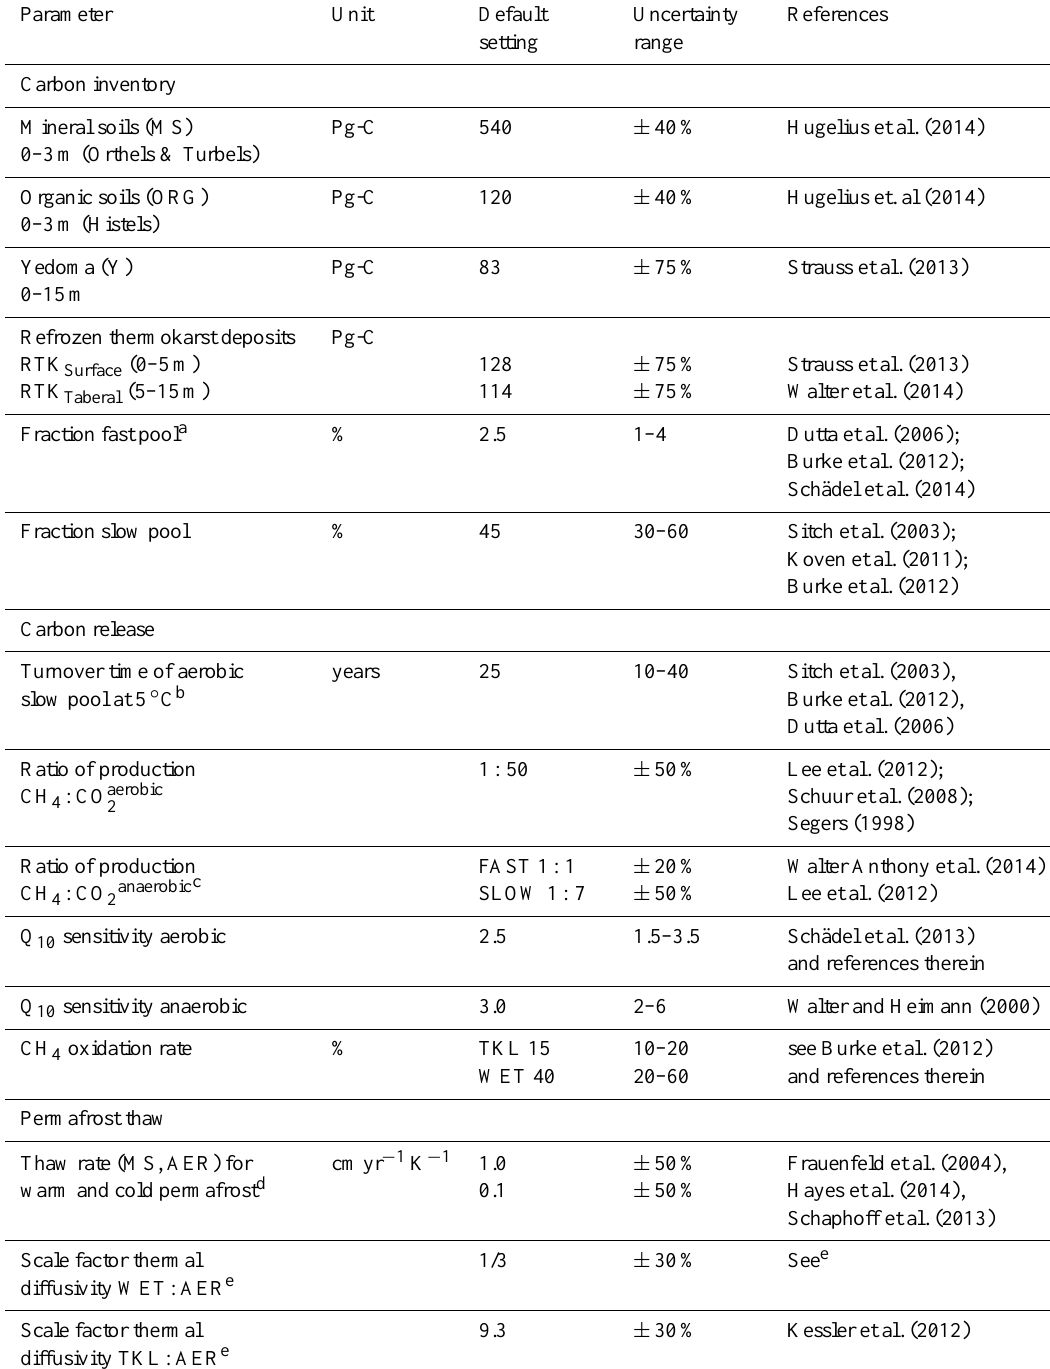
Table 1. Permafrost model parameters and uncertainties. Some parameters are soil pool specific (MS: mineral soils, ORG: organic soils, Y: Yedoma, RTK: refrozen thermokarst deposits – separated into surface and taberal sediments), some parameters depend on hydrologic conditions (AER: aerobic, WET: wetland anaerobic, TKL: thermokarst lake anaerobic) and some parameters depend on organic matter quality (FAST and